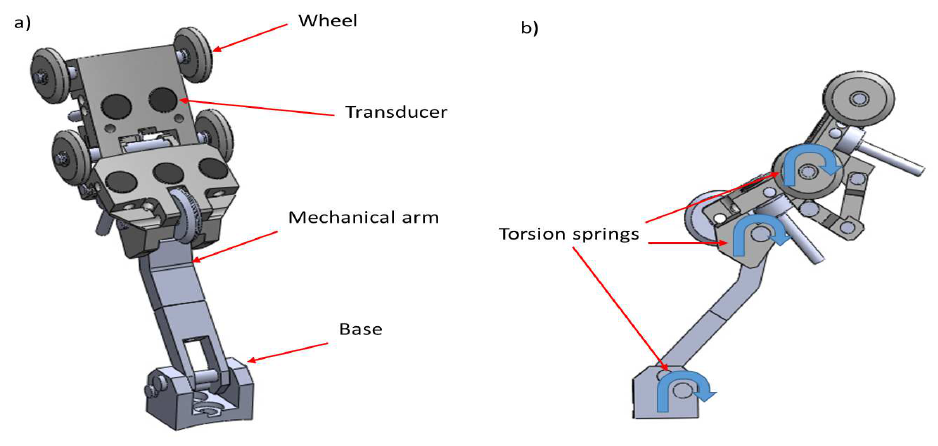
Figure 6. Articulated sensor carrier with piezoelectric transducers. ( a ) isometric view; ( b ) lateral